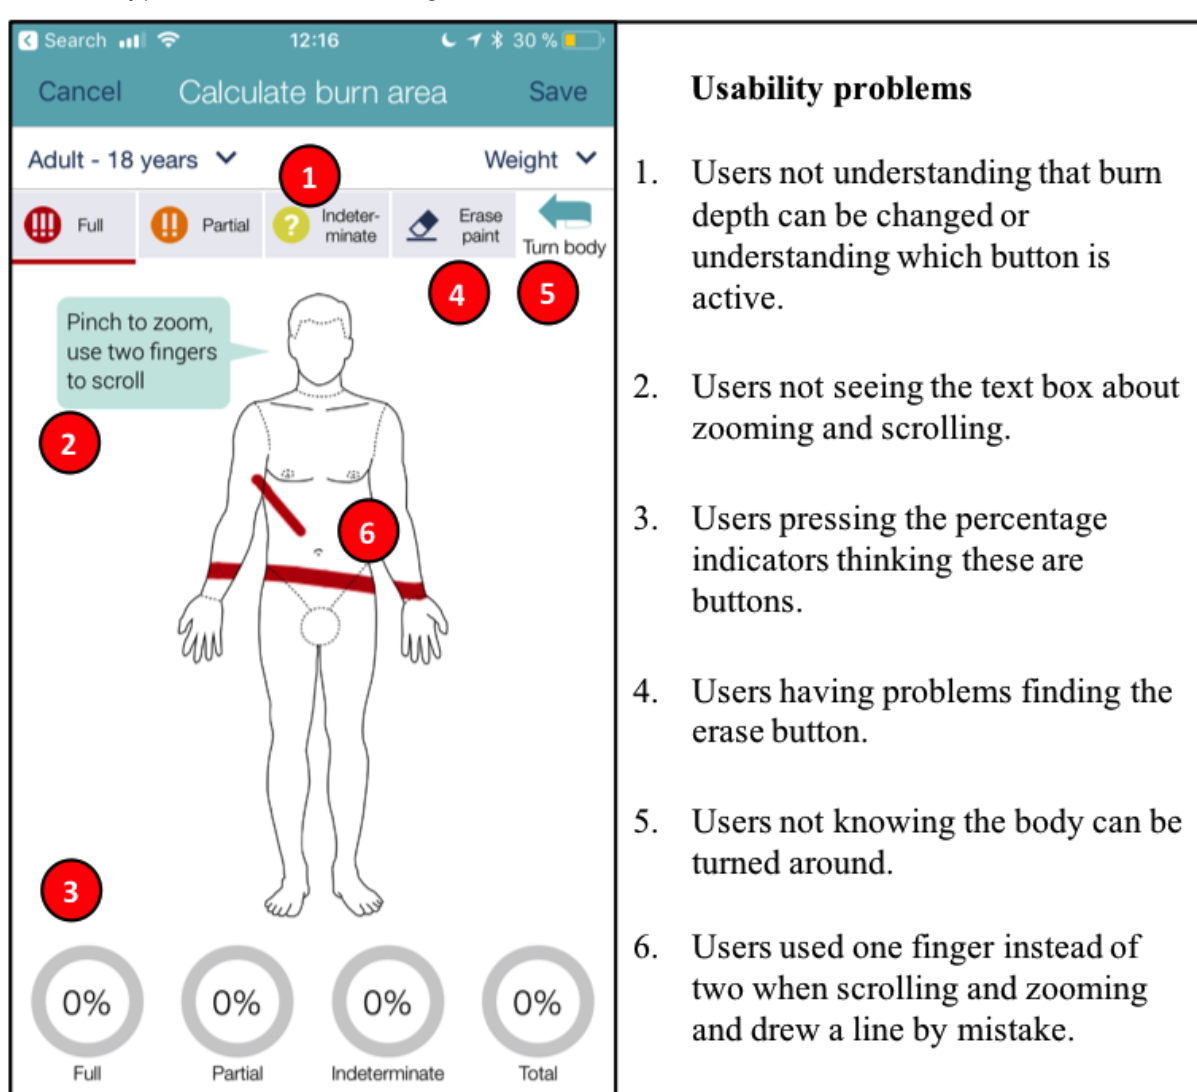
Figure 3. Usability problems identified in the drawing